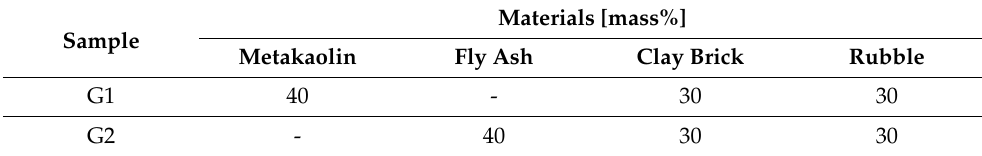
Table 3. Samples